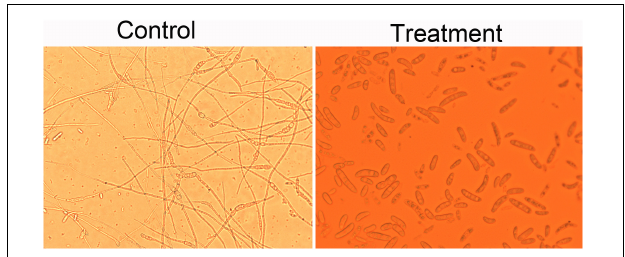
FIGURE 4 | Effects of the crude extracts of Streptomyces sp. SCA3-4 on spore germination of Foc TR4. Control, treatment with 10% DMSO; Treatment, treatment with the crude extracts (100 µ g/ml) of Streptomyces sp.